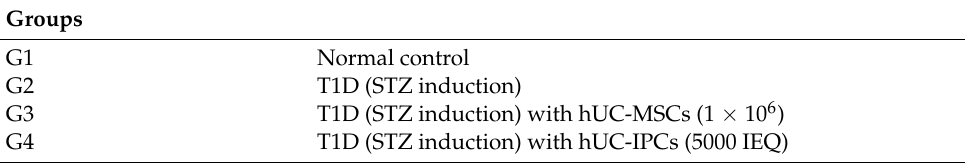
Table 4. Experimental scheme of T1D induction in 8-week-old male C57BL/6 mice injected with STZ (55 mg/kg), hUC-MSCs (1 × 10 6 ), or hUC-IPCs (5000 IEQ) intraperitoneally in G3 and G4,